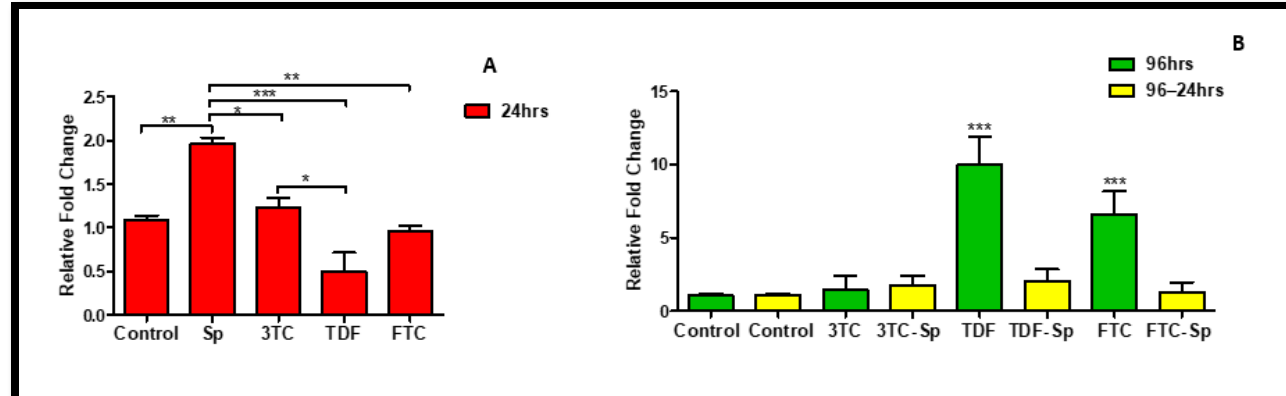
Figure 7. Effects of SP and HAART (3TC, TDF, and FTC) on CAT mRNA levels. CAT mRNA levels after exposure of HepG2 cells to ( A ): SP and HAART for 24 h, ( B ): HAART (96 h), and HAART (96 h) followed by SP (24 h); * p < 0.05, ** p < 0.005, *** p < 0.0001 .